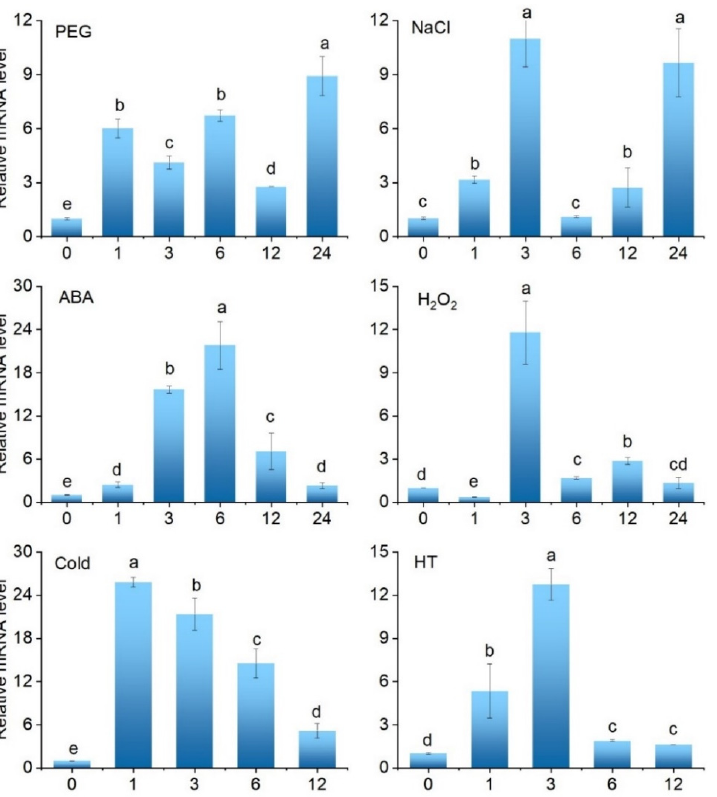
Figure 5. Expression levels of SlCML39 under different treatments. Tomato seedlings were treated with H 2 O, 20%PEG6000, 100 mM NaCl, 100 uM ABA, 10 mM H 2 O 2 , cold (4 °C), or high-temperature conditions (HT, 42 °C) for 1, 3, 6, 12, and/or 24 h. Total RNA was extracted from leaves and relative mRNA levels were determined by qRT-PCR using UBI gene as an internal control. The fold change was normalized relative to the level of H 2 O treatment. The bar represents the mean ± SD values of three replicates ( n = 3). According to the LSD test, the statistical differences between samples are marked with different letters ( p < 0.05).